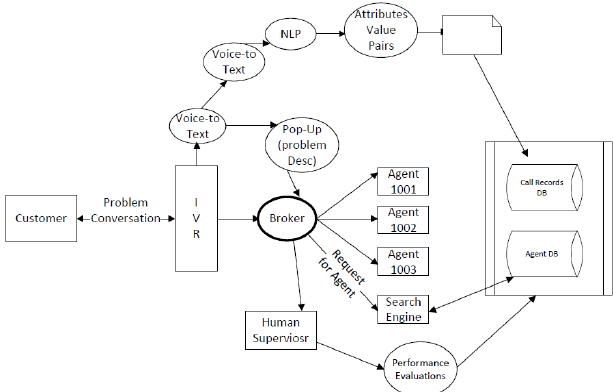
Figure 2 . Call center call processing